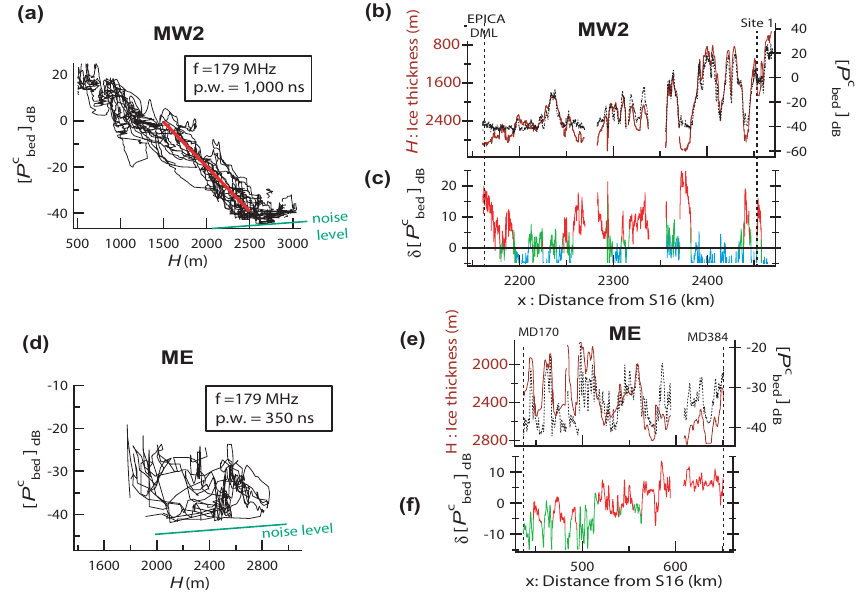
Fig. 6. Results along the legs in the mid-stream area. (a) H-P plot for leg MW2. The red line is the regression line to a depth of 2500m. (b) X-PH plot for the same leg. (c) X- δ P plot for the same data. (d) H-P plot for leg ME. The regression line was not derived because it was not possible to define an appropriate range for this line. (e) X-PH plot for the same data. The left- and right-hand axes were scaled and adjusted using the gradient of the regression line of P9. (f) X- δ P plot for the same data.